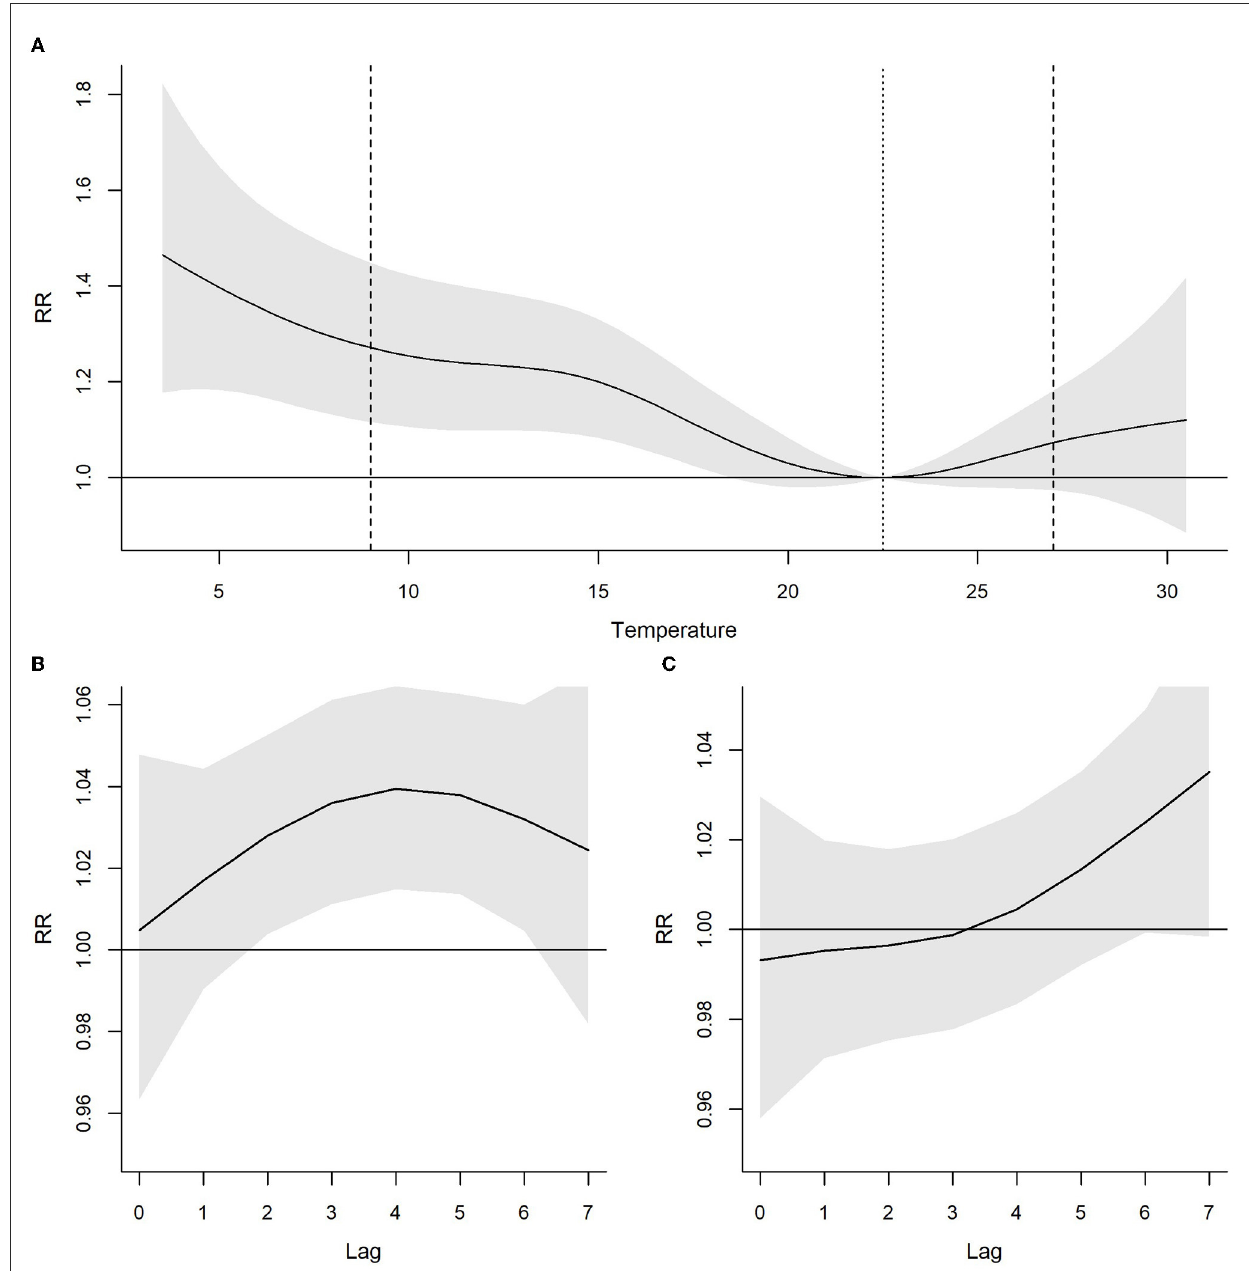
FIGURE1 Relationship between average temperature ( ◦ C) and risk of sickness absence in Barcelona for the period 2012–2015 with 95% confidence intervals. (A) Cumulative Relative Risks (RR) for lags 0–7. The dashed lines indicate the 5th and 95th percentiles of average temperature. The dotted line indicates the temperature of minimum risk. (B) Association of cold temperatures (RR for 5th percentile of temperature compared to temperature of minimum risk) by lag. (C) Association of hot temperatures (RR for 95th percentile of temperature compared to temperature of minimum mortality) by lag.